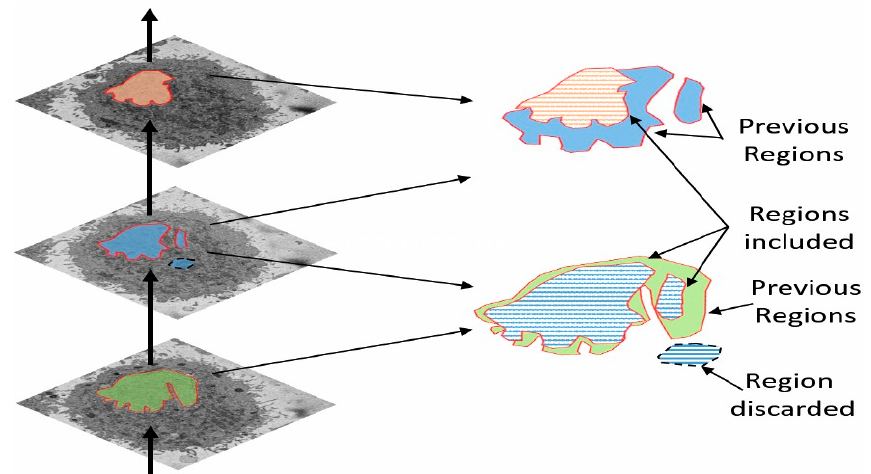
Figure 3. Illustration of the propagation regions. Regions of a slice that overlap with the regions of a previous segmentation are maintained, whilst regions that do not are discarded. The algorithm propagates up and down, starting from central slice (slice number 150 for all seven cells which were segmented in this work), in the same way as a human expert to include or discard regions.